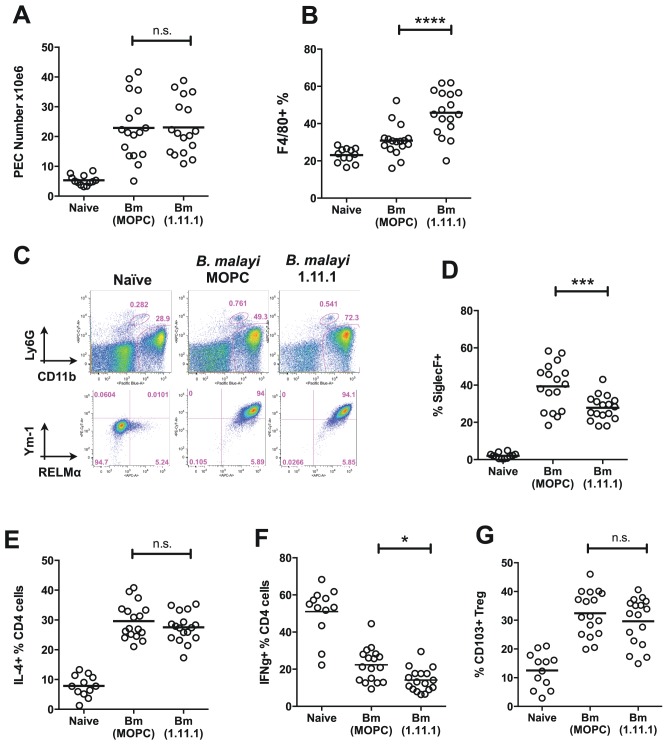
Altered T cell, eosinophil and macrophage responses in mice receiving neutralising anti-Bm-TPI monoclonal antibody.
A. Peritoneal cell recruitment in recipients of 1.11.1 anti-Bm-TPI monoclonal antibody or control IgG1 myeloma protein MOPC31C, in mice 28 days following transplant of adult B. malayi worms. B. Peritoneal CD11b+ F4/80+ macrophages as in (A). C. Intracellular expression of Ym-1 and RELMa by peritoneal macrophages (CD11b+ F4/80+ Ly6G− siglecF−) in mice 14 days following transplant of adult B. malayi parasites with 1.11.1 anti-Bm-TPI monoclonal antibody or control IgG1 myeloma protein MOPC31C. Representative of 4 mice per group. D. Peritoneal CD11b+ siglecF+ cells as in (A). E. Intracellular IL-4 production by CD4+ peritoneal T cells as in (A) F. Intracellular IFN-γ production by CD4+ peritoneal T cells as in (A). G. Frequency of CD103+ expression among Foxp3+ Tregs as in (A). Data in (A–B, D–G) are pooled from 4 independent experiments.